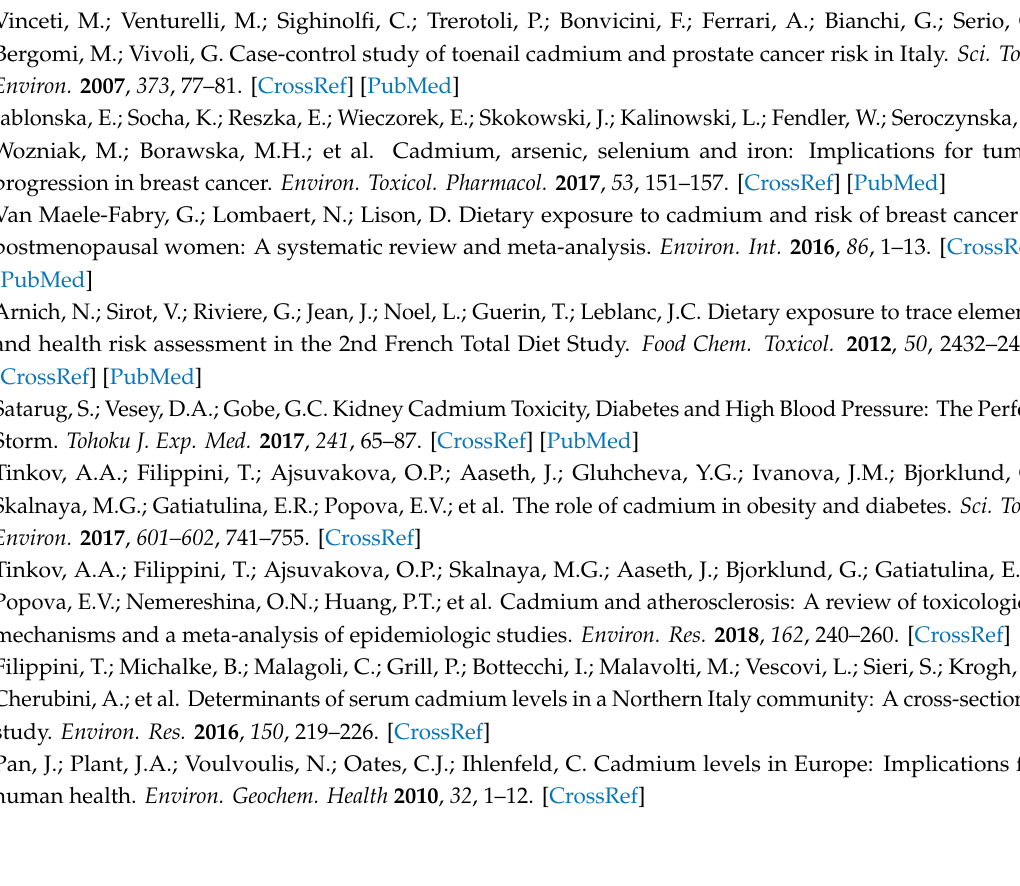
Table S1: Linear regression coe ffi cients (Beta) and 95% confidence intervals (CI) between serum cadmium and relevant confounders for adjustment levels, Table S2: Estimated weekly dietary intake (median (50th) and interquartile range (IQR) reported in µ g per kilograms of body weight per week) using food frequency questionnaire (WDI FFQ ) and using serum cadmium biomarker levels (WDI bio ) in total population and in select subgroups considering a value of 3% for cadmium absorption in Equations